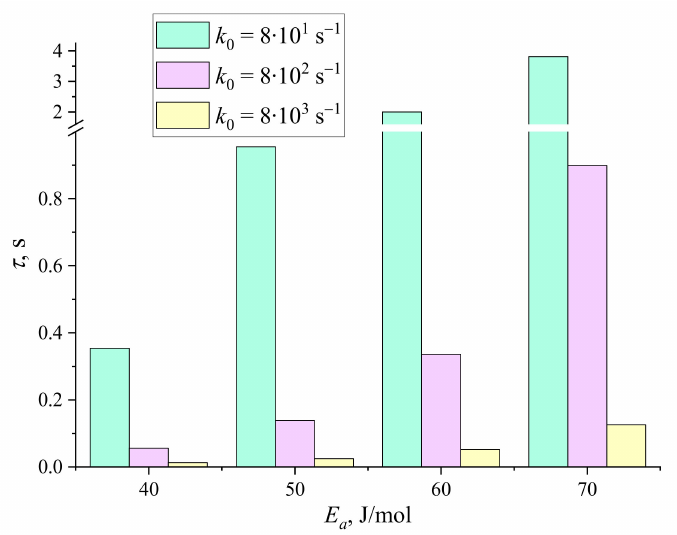
Figure 9. Theoretical dependency of the ignition delay time τ on E a when k 0 is varied under the conditions of conductive heating ( T = 1173